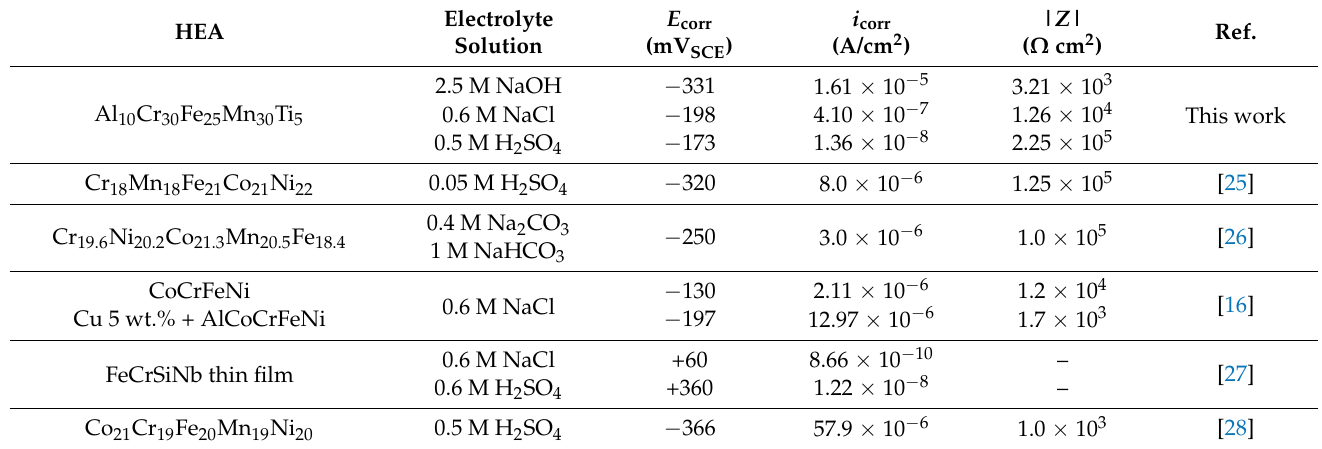
Table 4. Corrosion properties comparison between different HEAs. Electrolyte HEA